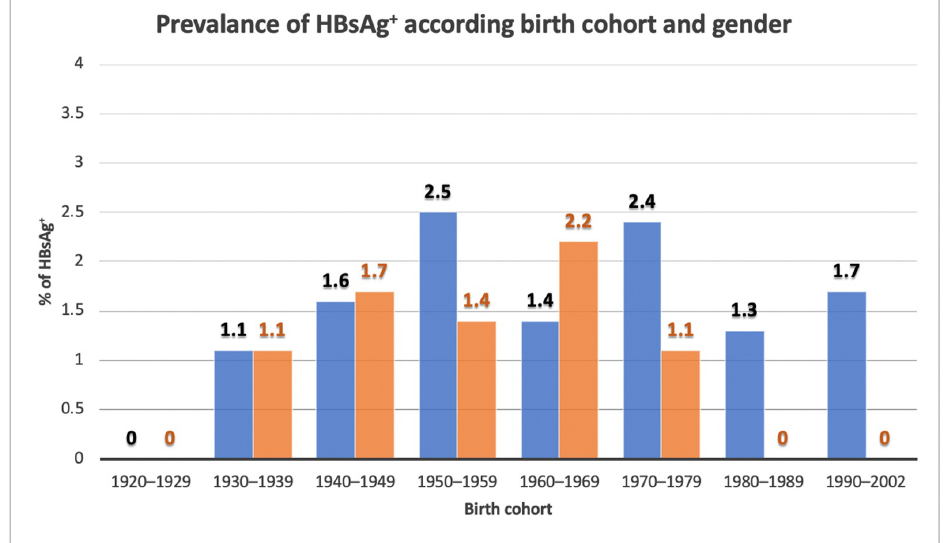
Figure 4. HBsAg seroprevalence, according to the birth cohort and gender.